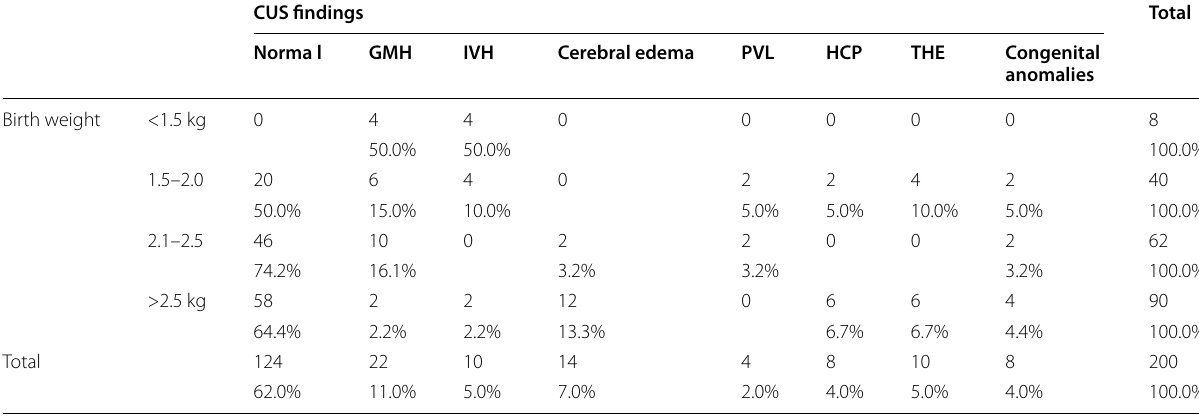
Table 3 Frequency of various CUS findings with birth weight CUS